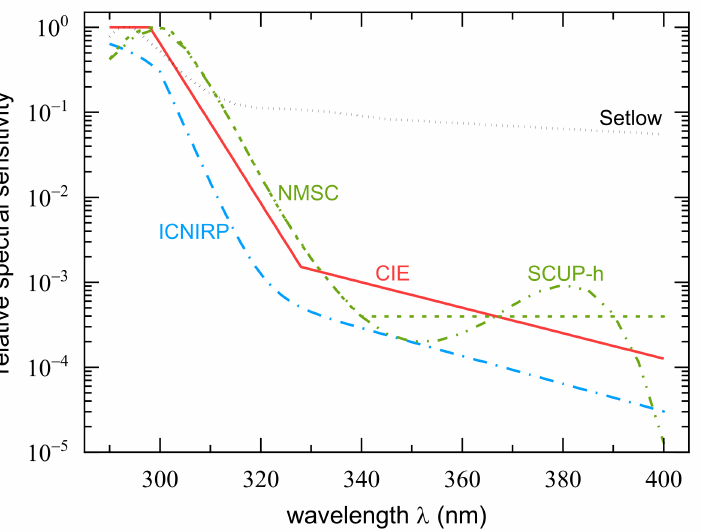
Figure 1. Semilogarithmic presentation of the CIE standard curves for erythema [24] and for non- melanoma skin cancer (NMSC) [25], the latter with one of its predecessors, the Skin Cancer Utrecht- Philadelphia action spectrum modified for human epidermal absorption (SCUP-h) [23]. ICNIRP’s UVR hazards reference weighting function [31] and the cutaneous melanoma sensitivity proposed by Setlow [27] are also presented. Further information is given in Table 1